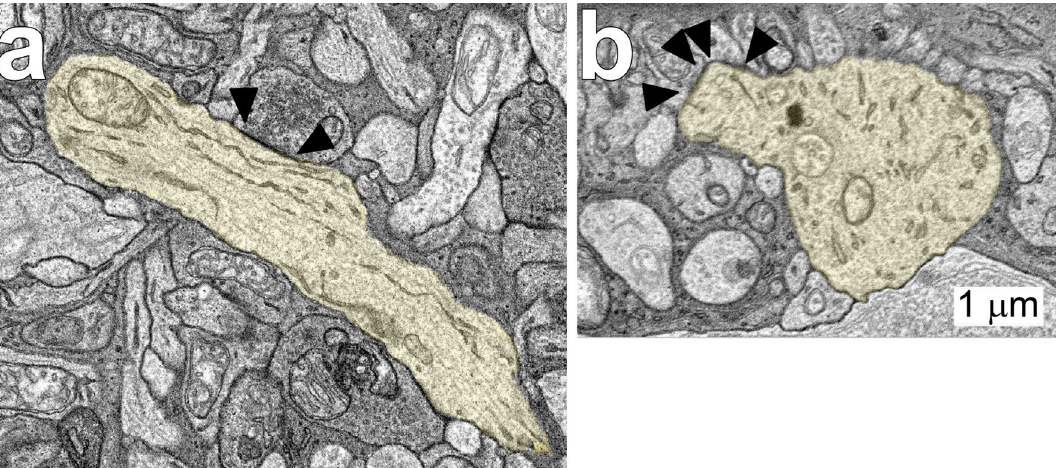
Figure 3. Displaced M1 ipRGC 11,345 (yellow) received synapses ( ▲ ) from amacrine cells on its dendrites. Amacrine cells provided the major synaptic input to this and other displaced